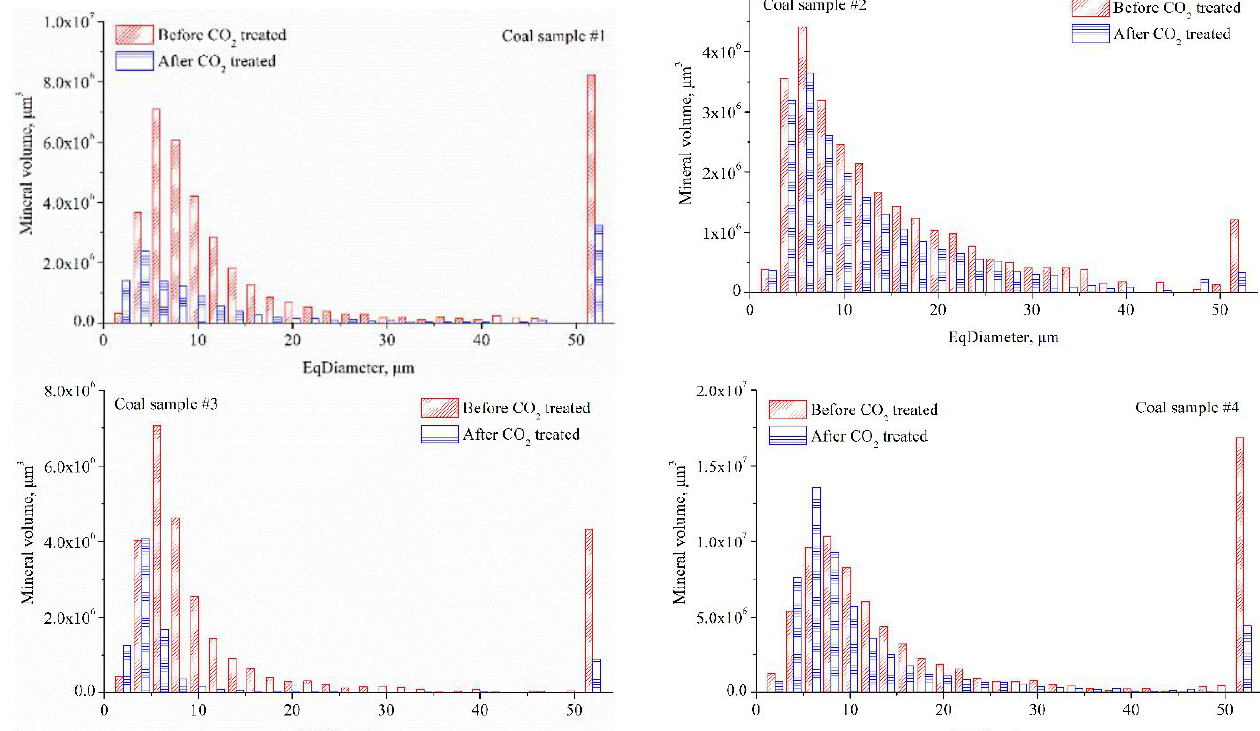
Figure 8—Mineral volume distributions of coal samples based on X-ray